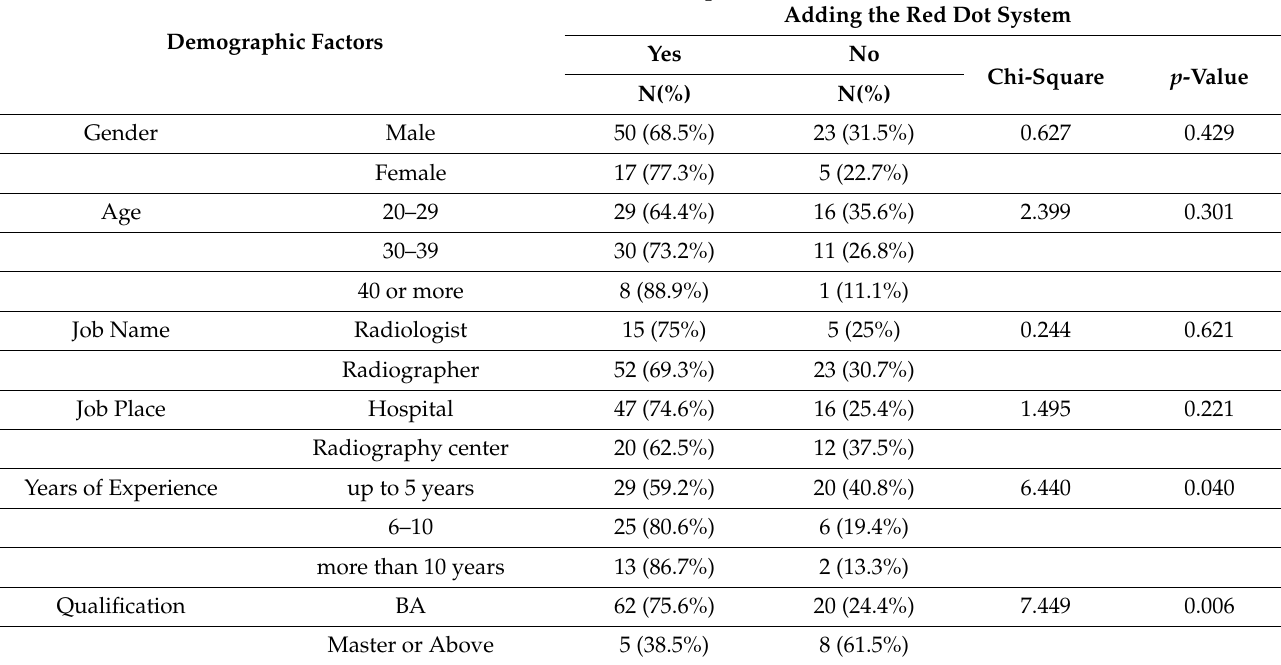
Table 7. Effects and results of adding the red dot